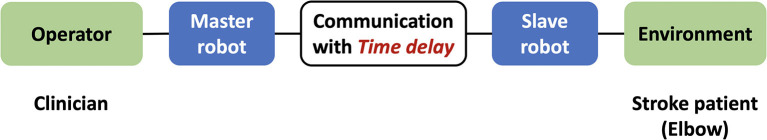
Telerobotic remote assessment.